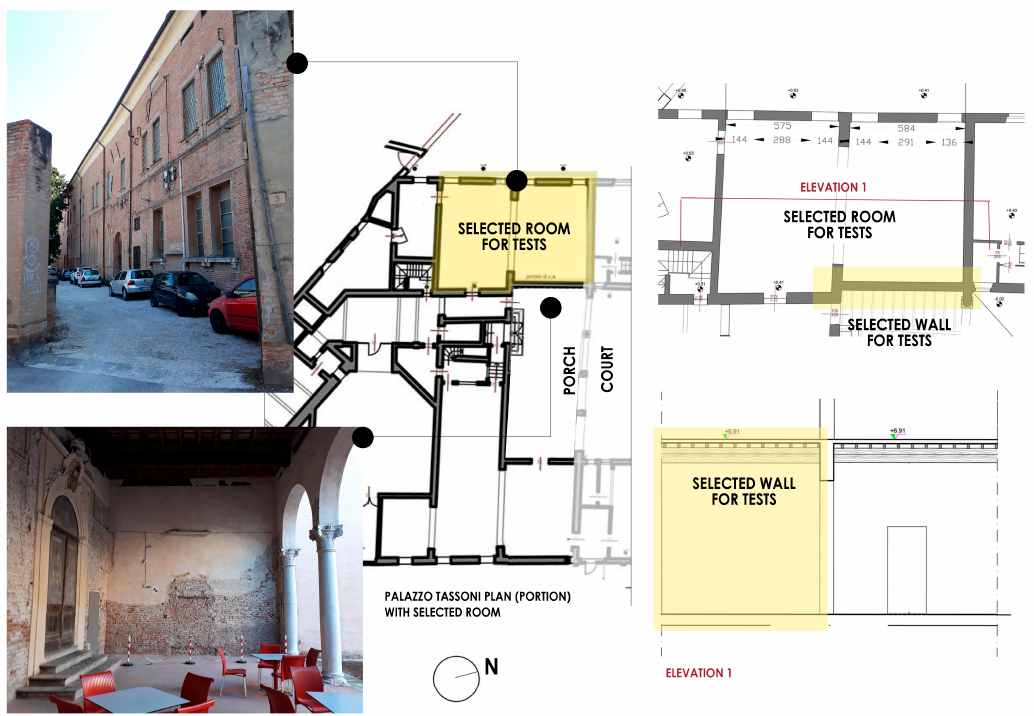
Figure 1. Palazzo Tassoni Estense: ground floor plan with the identification of the room where the experiment is carried out. Views of the external walls of the selected room: the one on the top left represents the front view from via Cammello, the one on the bottom left is a view of the wall under the porch (selected to be studied). The yellow shape underlines the selected room and the corresponding wall selected for the tests.